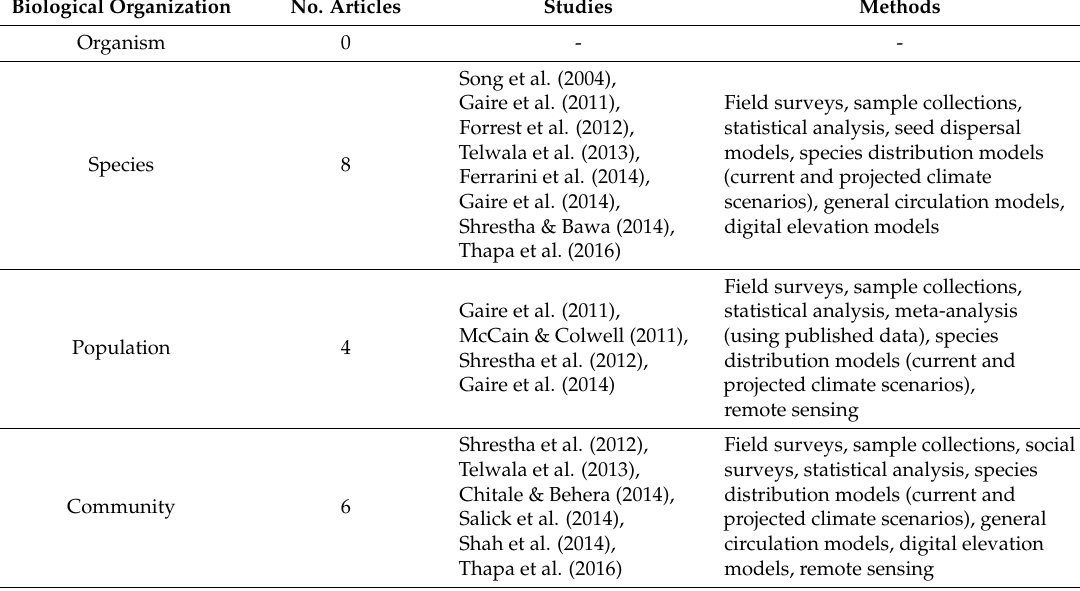
Table 2. Studies reviewed and their approaches, organized based on Scheffers et al. framework